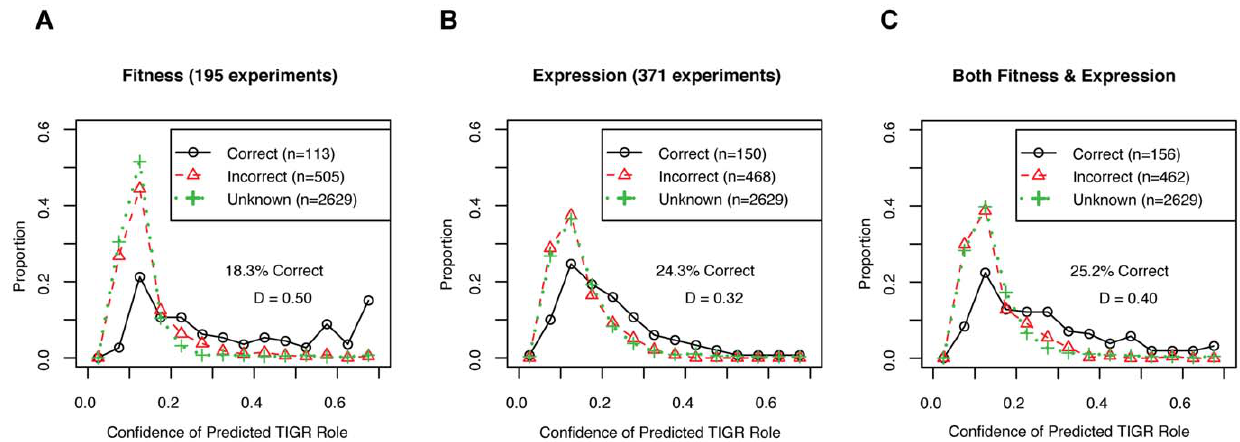
Figure 7. Mutant fitness gives confident predictions of gene function. (A) We used 195 fitness experiments to predict TIGR functional groups or subroles. We show the distribution of confidence values for correct and incorrect predictions for the 618 genes with subroles assigned by TIGR and also the distribution of confidence values for the 2,629 genes that were not assigned subroles by TIGR (in green; marked as unknown). The confidence of correct predictions is significantly better than for the incorrect predictions (Kolmogorov-Smirnov test; D=0.50, P-value , 1e 2 15 ). (B) Same as (A) but using 371 microarray gene expression experiments. (C) Same as (A) but using both 195 pooled fitness experiments and 371 gene expression